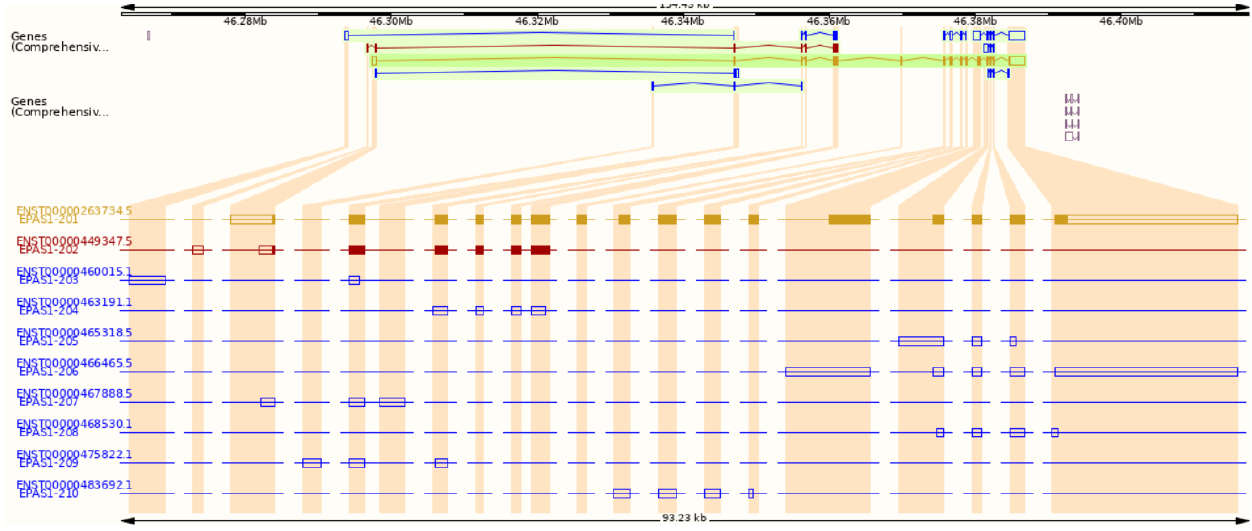
Figure 2. Transcripts of the EPAS1 gene from the Ensembl genome browser. Gold and red indicate protein-coding transcripts, blue indicates non-coding transcripts.